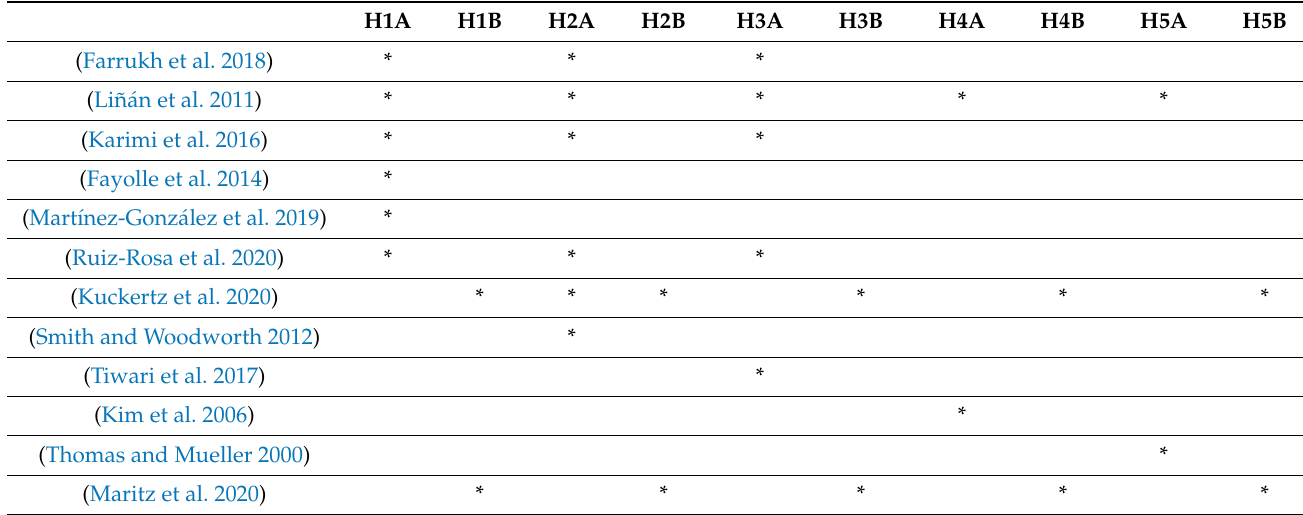
Table 1. Relevant literature for the formulation of hypotheses. (* refers authors who provide theoretical contributions to the hypotheses under